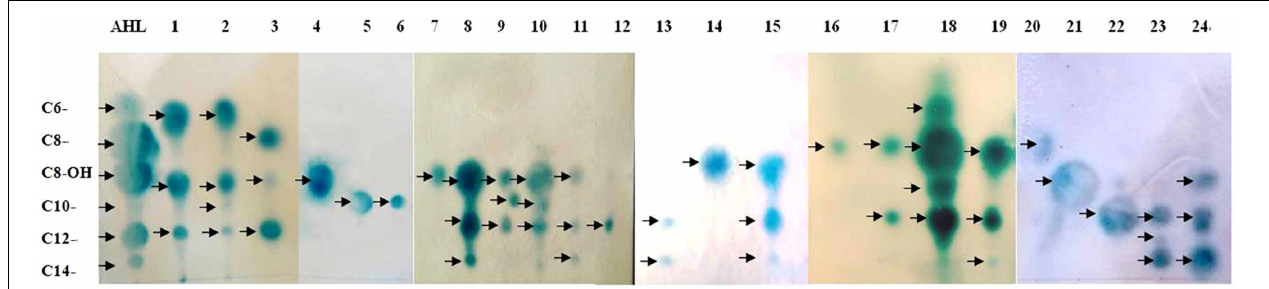
FIGURE 2 | Analysis of AHLs from supernatant extracts with the sensor strain. AHLs extracted from cell-free culture supernatants were separated by thin-layer chromatography (TLC) and detected using an overlay of agar seeded with A. tumefaciens 136. Line AHL are the QS standards (arrows point to C6-, C8-, OH-C8-, C10-, C12-, and C14-AHL, respectively). Lines 1–24 represent the sample extracts. The strain names were: Enterobacter sp., Pasteurella pneumotropica , Photobacterium rosenbergii , Vibrio fluvialis , Gallaecimonas sp., Staphylococcus xylosus , Vibrio sinaloensis , Brachybacterium paraconglomeratum , Bacillus